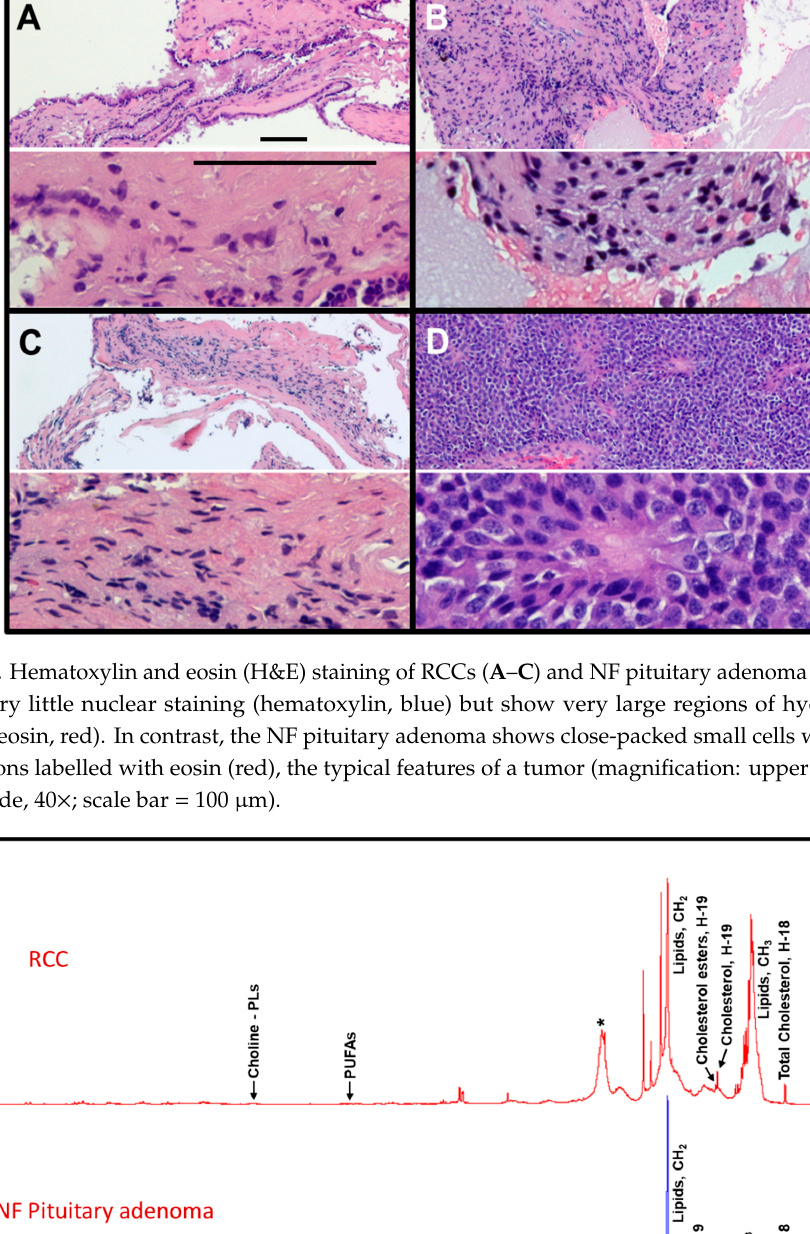
Figure 5 . Charts showing concentrations of aqueous metabolites and lipid molecules (expressed in µmol/g, wet weight of sample, mean ± S.D.) in NF pituitary adenomas and RCCs. In comparison with pituitary adenomas, low levels of lactate, alanine, Cr/PCr, taurine and very high levels of N-acetyl sugars or GAGs were present in RCCs ( A ). Relatively lower levels of cholesterol, PUFAs and Choline- PLs were present in RCCs ( B ). 3. Discussion In the current study, we have determined the metabolic composition of RCCs and compared it with that of NF pituitary adenomas by 1D and 2D 1 H NMR spectroscopy and identified unique metabolites which can be used to differentiate RCCs from the NF pituitary adenomas. We found that